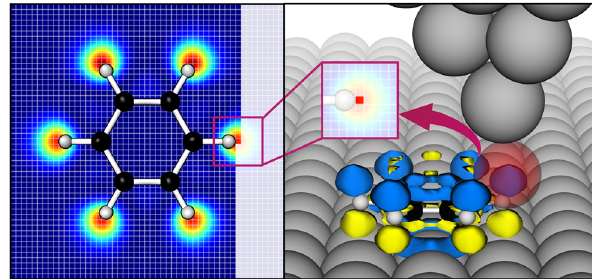
Fig. 1 Schematic representation of locally integrated Raman polarizability density. The Raman polarizability density of the normal mode at 664 cm − 1 of a benzene molecule is illustrated by isosurface (right panel). The density distributions in blue and in yellow hold the positive and negative signs, respectively. The red sphere denotes the con fi ned near- fi eld distribution at its FWHMs. The Raman polarizability densities in the red sphere are drastically enhanced and spatially integrated giving rise to a Raman intensity (symmetric bending) at 664 cm − 1 (in insert). TERS image is generated from locally integrating Raman polarizability density by tip scanning over a benzene molecule (left